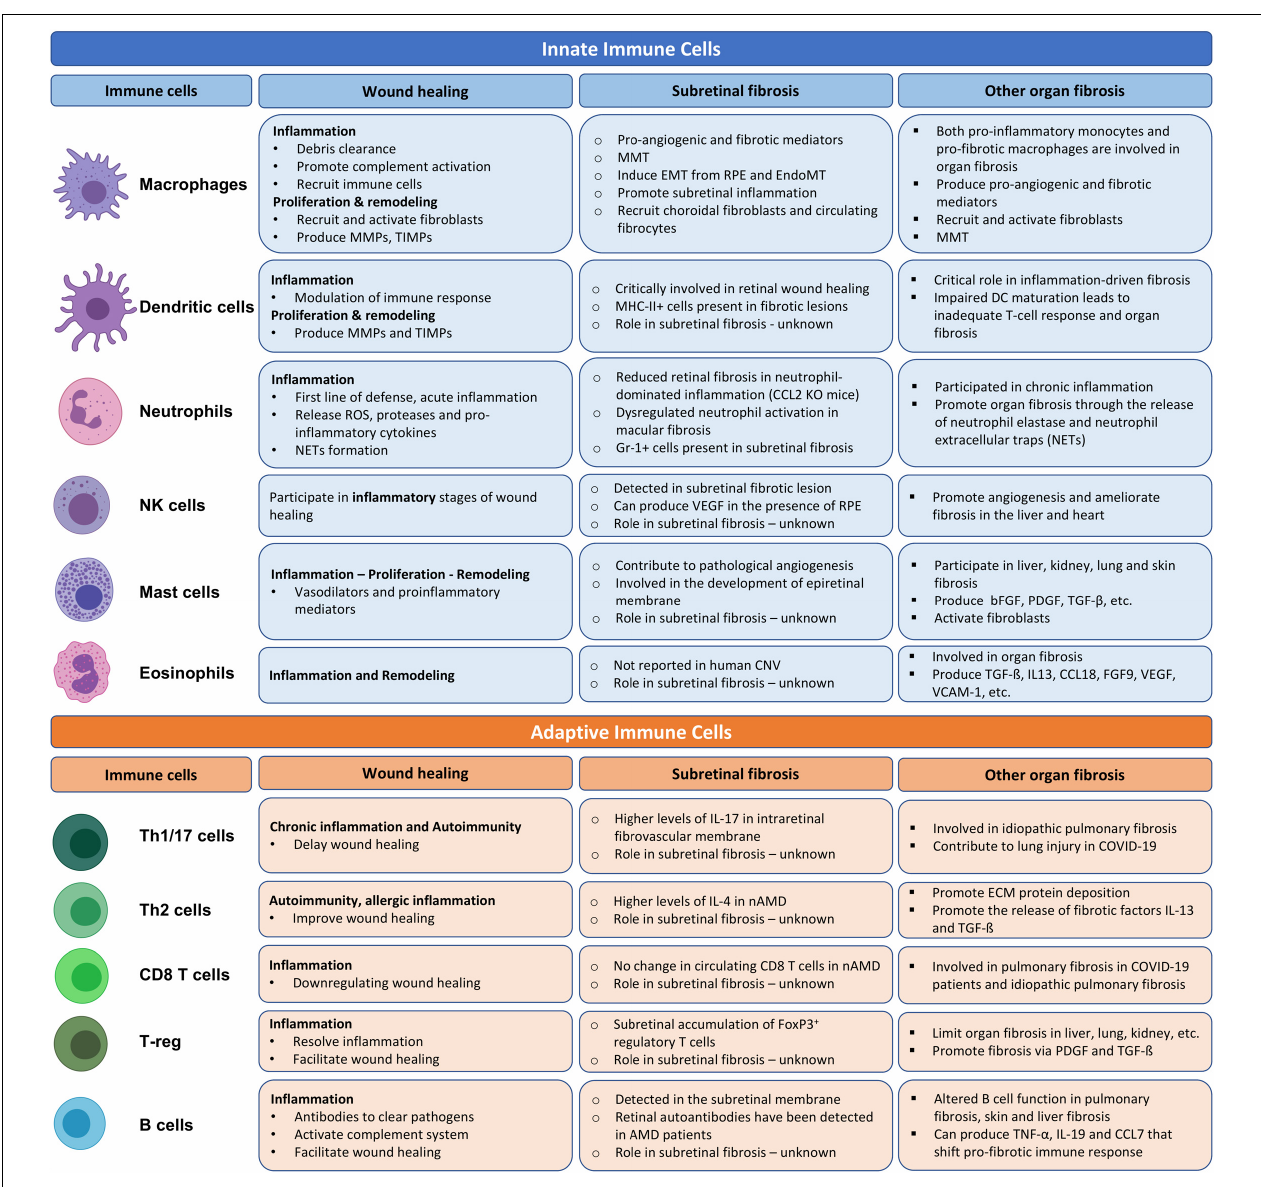
FIGURE 2 | The role of innate and adaptive immune cells in wound healing, organ and subretinal fibrosis. Cells were adopted from BioRender.com.